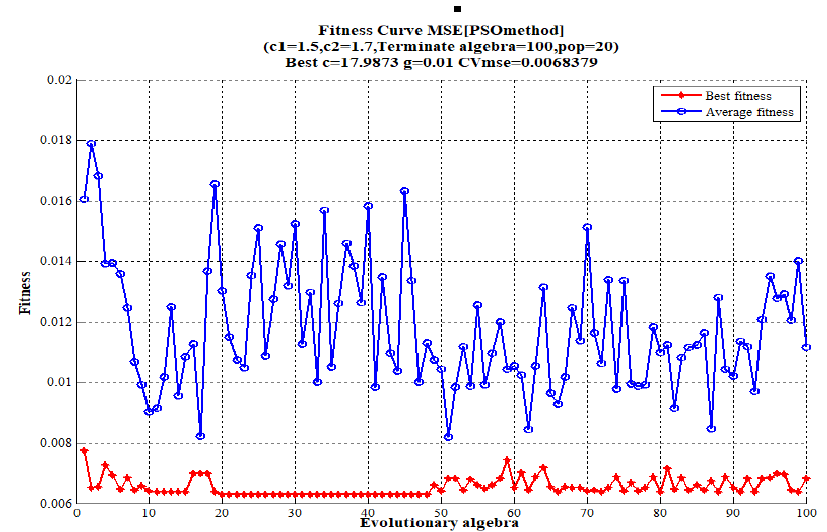
Figure 6. The fitness curve of the particle swarm optimization algorithm.